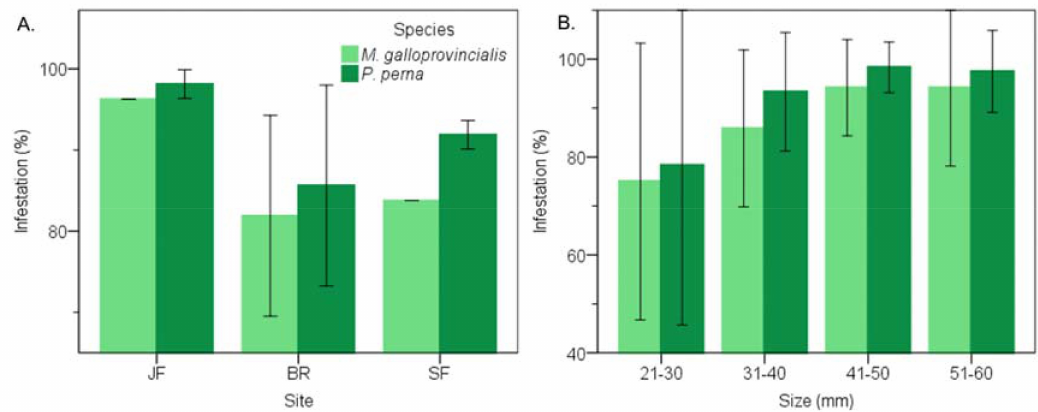
Figure 5. Overall prevalence of infestation (%; ± 95% CI) for Perna perna and Mytilus galloprovincialis along the warm temperate bioregion where both species coexist. Data grouped by ( A ) site with size classes pooled and ( B ) by size class with sites pooled.